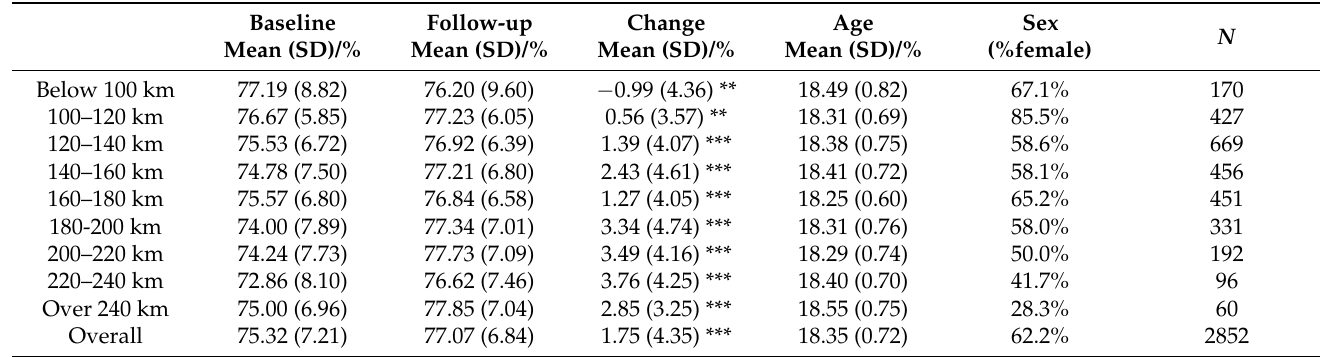
Table 1. Descriptive statistics of participants by total outdoor jogging mileage ( N = 2852).